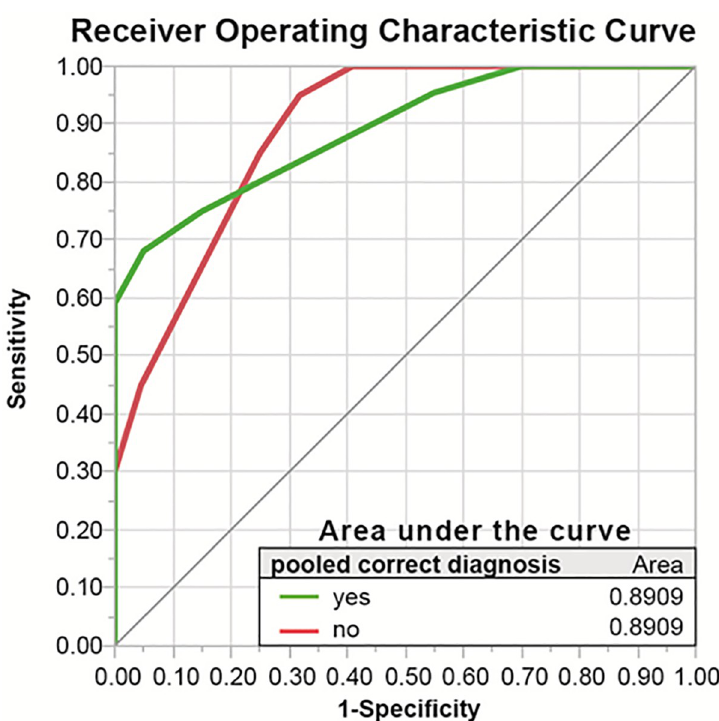
Fig 9. Receiver operating characteristic curve. This figure shows the receiver operating characteristic curve of the decision tree analysis based on the tumor-to-background ratio thresholds of the employed sequences.